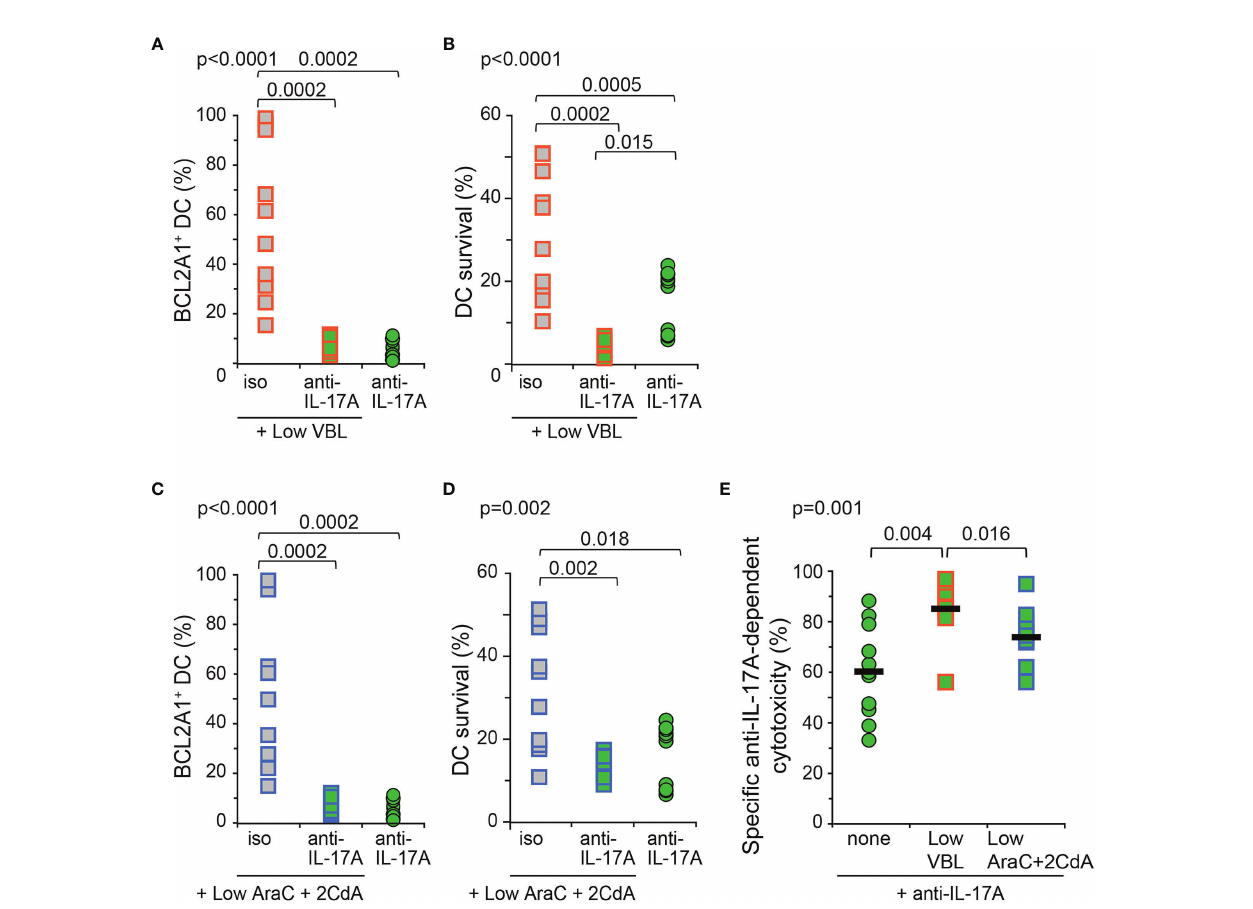
FIGURE 5 | BCL2A1 expression and survival of Mo-DCs from LCH patients after combined in vitro treatment with toxic compounds and neutralizing anti-IL-17A antibodies. Mo-DCs from LCH patients were cultured with low doses of toxic compounds in the presence of isotype control (iso) or anti-IL-17A Abs (anti-IL-17A), and compared to Mo-DCs from LCH patients cultured with neutralizing IL-17A Abs alone. (A, C) Intracellular BCL2A1 staining was performed 12 hours before (B, D) DiOC 6 /PI staining, operated at day 7 and calculated per million cultured Mo-DCs. (A – D) Mo-DCs from LCH patients were incubated with low doses of (A, B) VBL or (C, D) AraC and 2CdA. (E) Speci fi c anti-IL-17A-dependent cytotoxicity was calculated using [survival without anti-IL-17A – survival with anti-IL-17A]/survival without anti-IL17A x 100 for each 11 patients from the survival data shown in B and D. Bars represent the mean for all 11 patients. (A – E) The mean of triplicate values was plotted for each patient. SD were below 2%. One symbol corresponds to one patient. Mo-DCs from 11 LCH patients (p1b, p2b, p7c, p6b, p9, p12, p13, p14, p16, p19, p20) were analysed. Statistical analyses: the Kruskal-Wallis test with Steel-Dwass-Critchlow-Fligner post-test were used to compare the groups and calculate the p